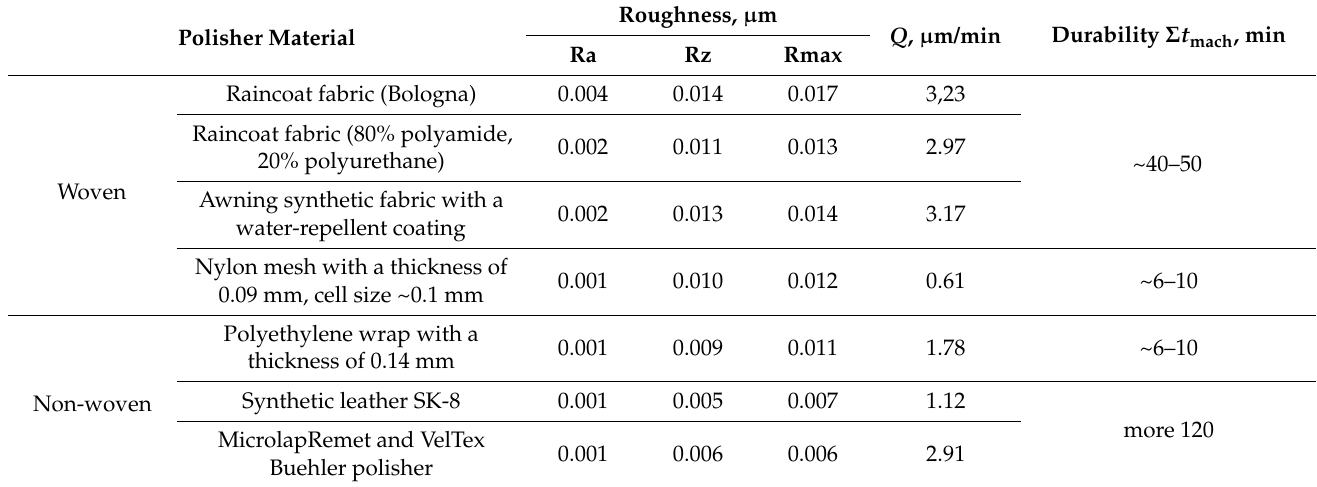
Table 4. Polisher material influence on the indicators of the polishing process.